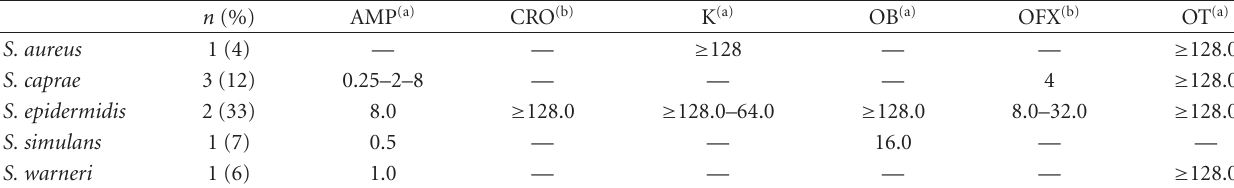
Table 3: Staphylococcus spp. with multiple resistance to antibiotics ( μ